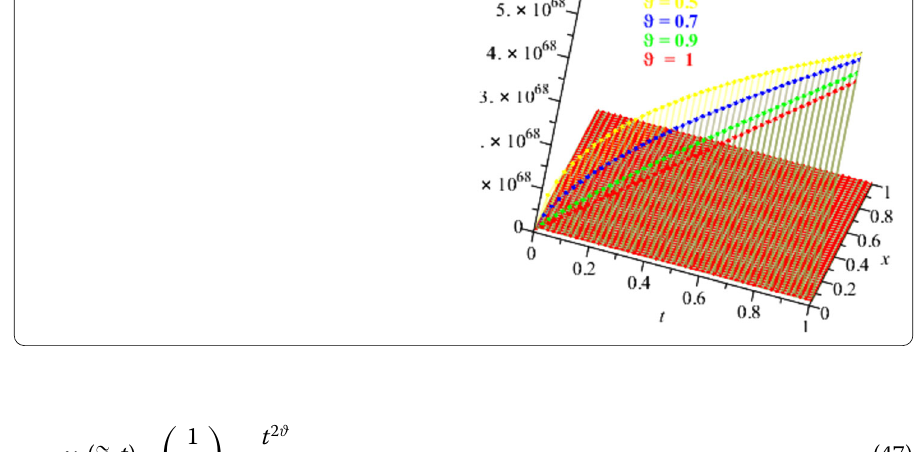
Figure 4 The fractional-order graph of Example